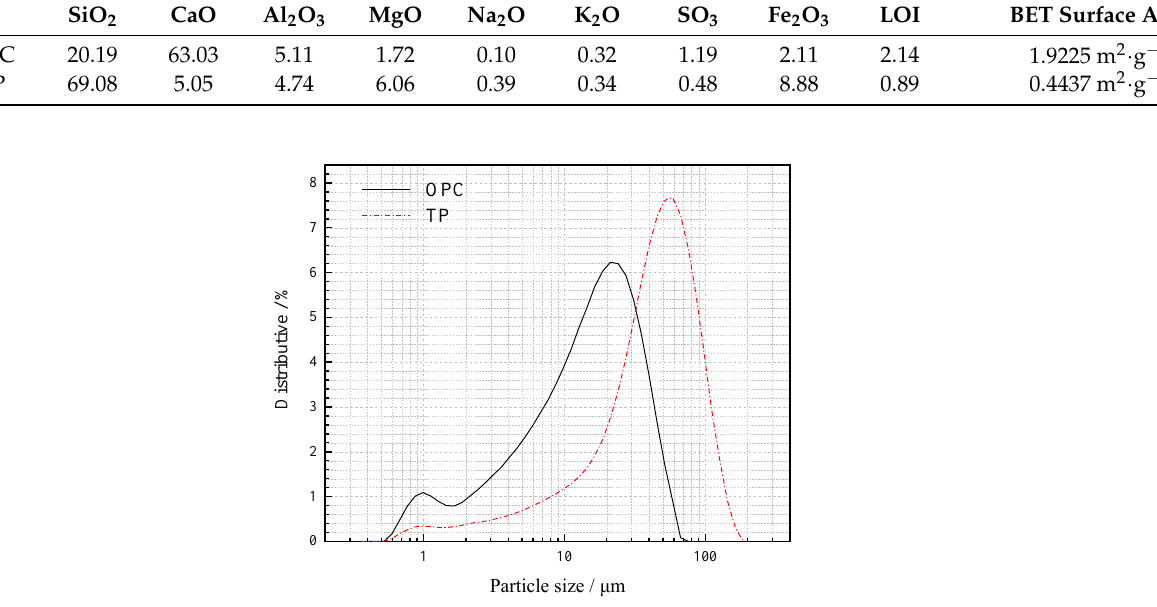
Table 1. The chemical composition of the cement.